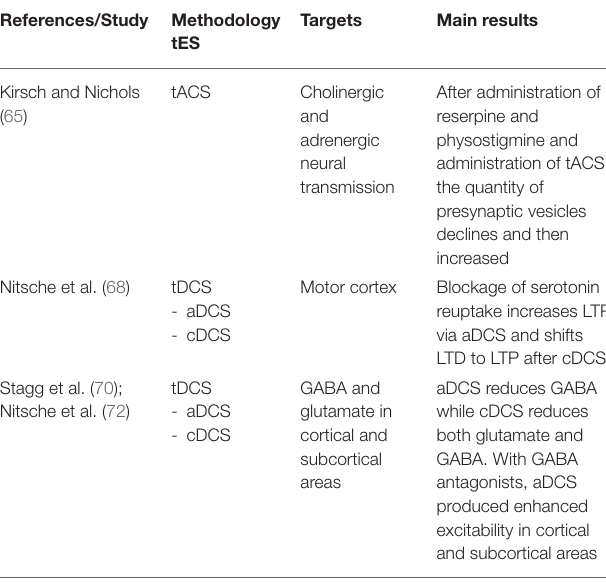
TABLE 2 | tES after-effects on neural